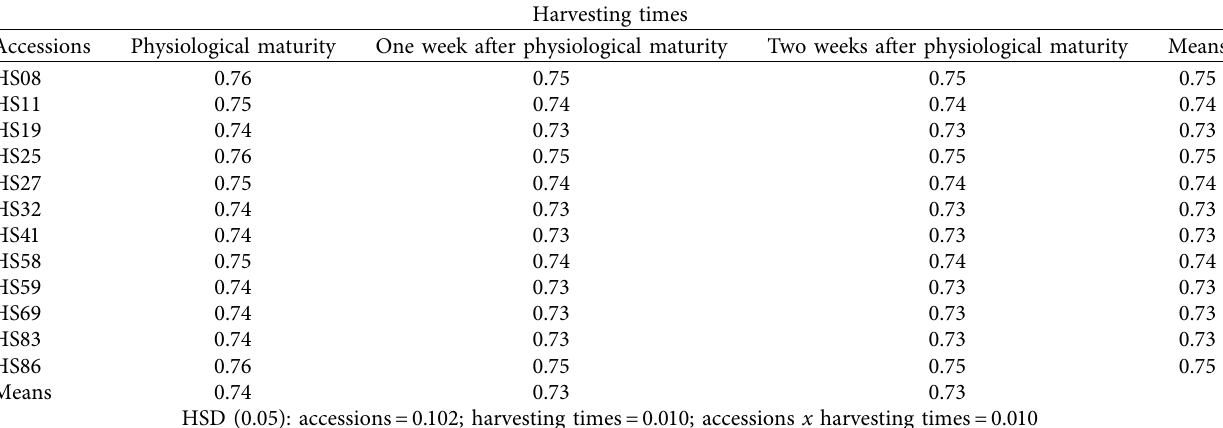
Table 8: Interactive effects of harvesting times x accessions on the degree of sphericity of seed of